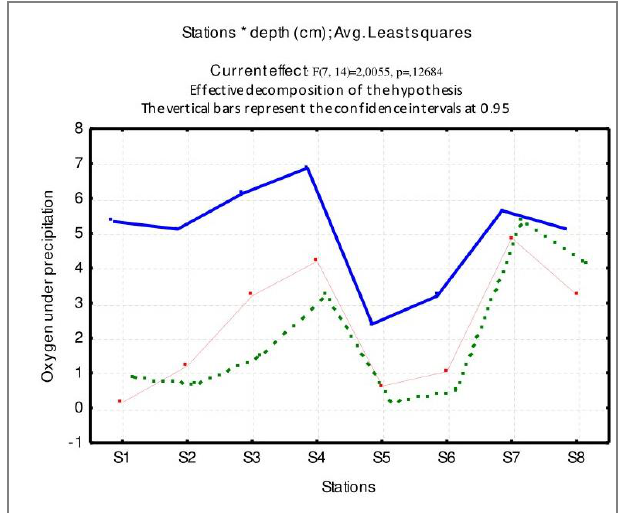
Figure 2. Spatial variation of the dissolved oxygen in a period of precipitation in mg/L in Reghaia